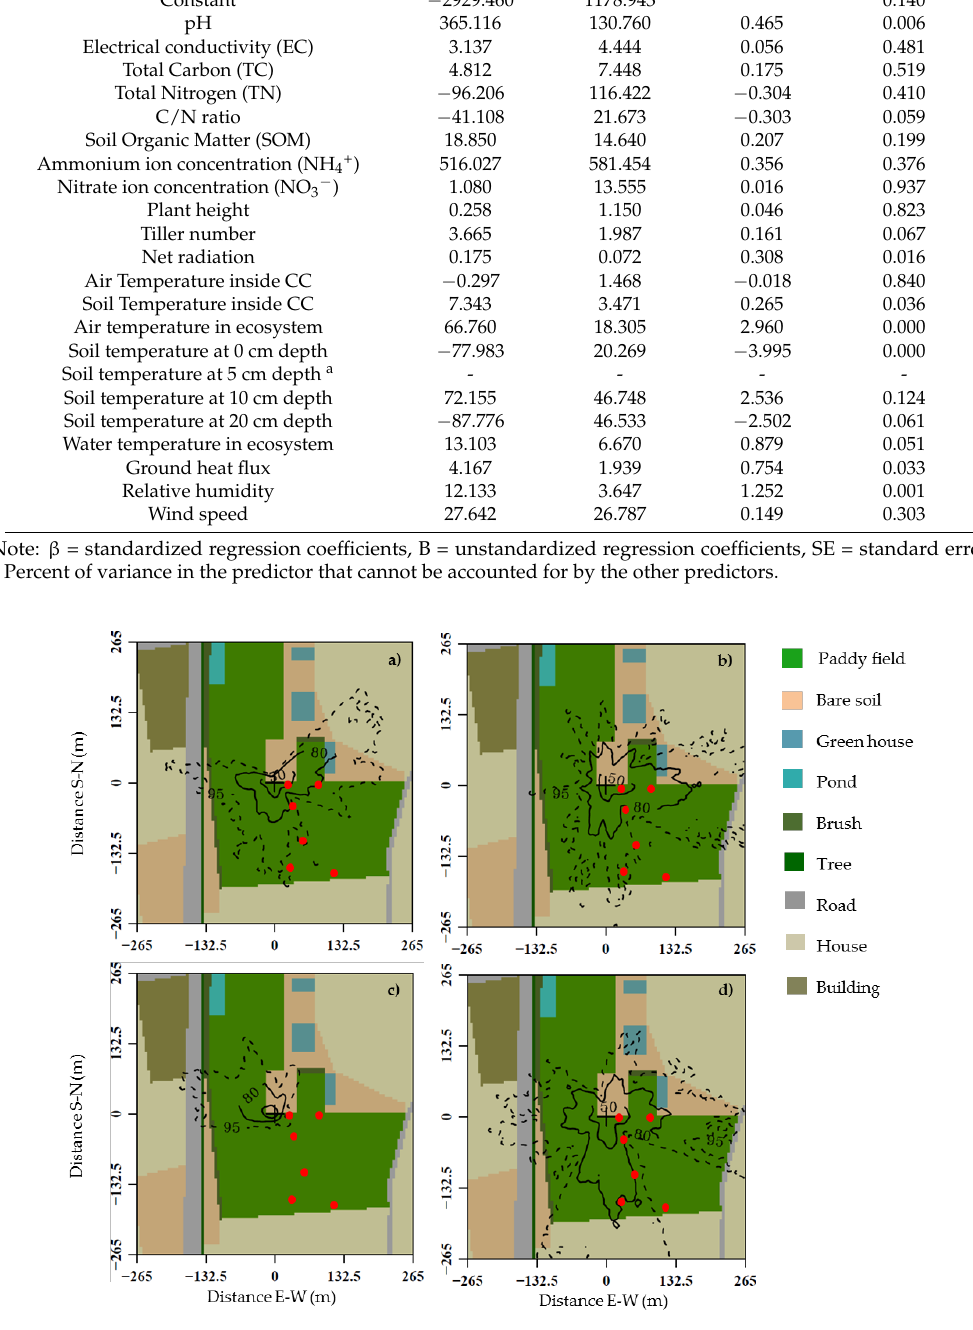
Table 2. Stepwise multiple regression analysis with environmental factors for surface CH 4 flux as measured using the CC method.